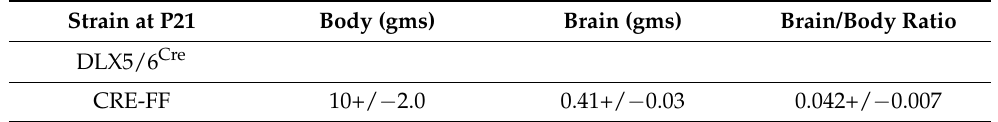
Table 4. Brain and Body Weights of Cell Specific Semaphorin 3F Deletion